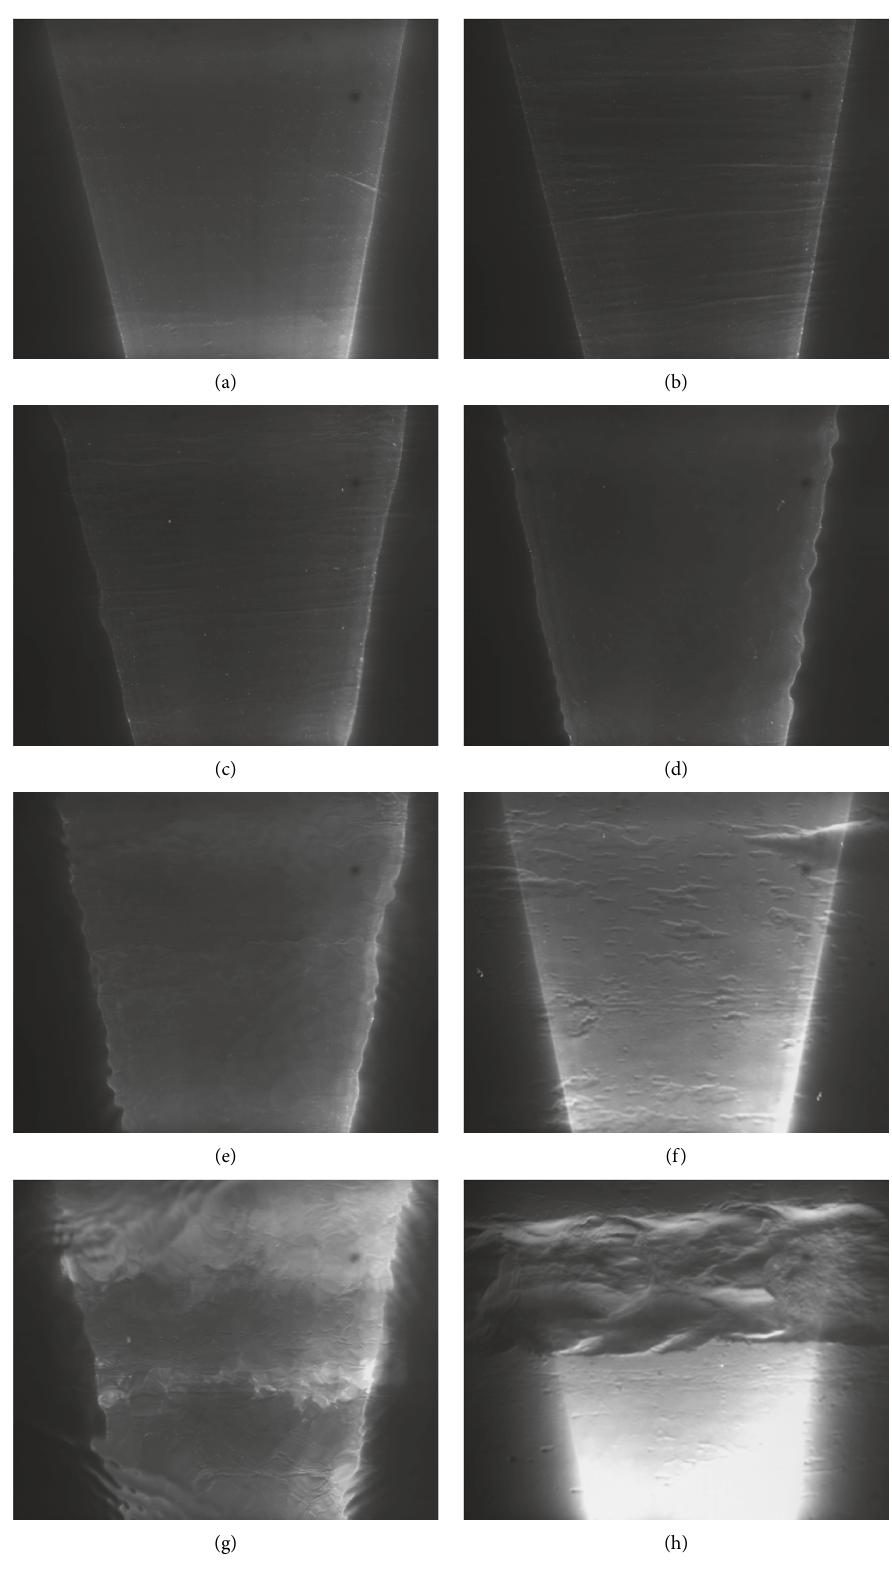
Figure 3: The phenomenon of muddy clay onset (10% salt water-0% salt clay mud). (a) The granular flocs. (b) Wispy stripes. (c) Dense stripes. (d) Sediment transport almost stops. (e) Sediment transport in the form of smoky. (f) Bed surface after sediment incipient movement. (g) Local scour. (h) Bed surface after